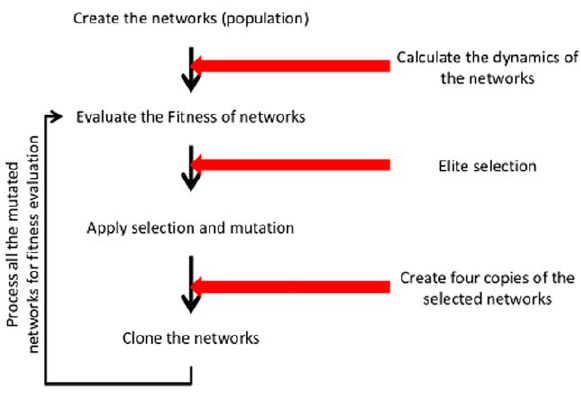
Figure 10. Scheme of the evolutionary algorithm. In order to generate genetic diversity, a set of 200 networks is created with diverse sets of kinetic parameters. In each iteration the dynamics of all networks is calculated for the complete set of input signals. Based on dynamics, the fitness is calculated. Based on the fitness scores, the successful network are selected (elite selection). For each selected network mutations are either applied to the kinetic parameters or the topology of the network by adding new proteins. Each selected network gives rise to an equal number of clones such that the population contains again 200